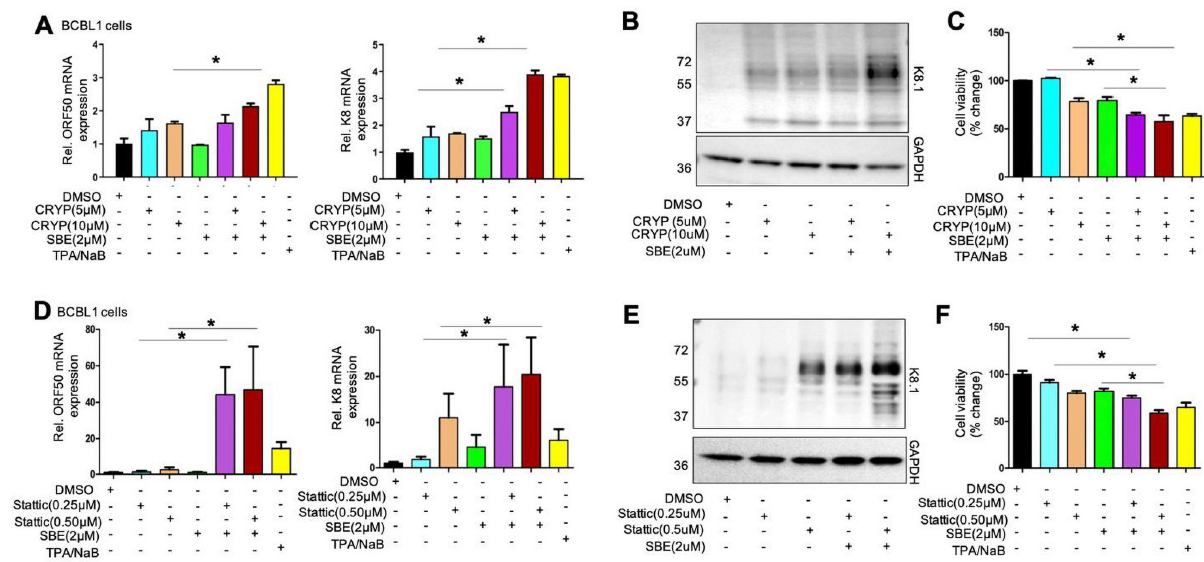
Fig 5. Inhibition of PLK1 and STAT3 efficiently induces KSHV lytic reactivation. (A, D) BCBL1 cells were treated with cryptotanshinone (CRYP, A) or stattic (D) in the presence or absence of SBE. TPA/NaB treatment was used as a positive control to reactivate latent KSHV. mRNA level of KSHV lytic genes (ORF50, K8) in these cells were measured by RT-qPCR and normalized to GAPDH. (B, E) Protein level of KSHV K8.1 in above cells (A, D) was measured by immunoblotting. GAPDH was used as loading control. (C, F) Cell viability of above cells (A, D) was measured by ATP-based assays and normalized to DMSO. Results were calculated from n = 3 independent experiments and presented as mean ± SD ( � p < 0.05; two-tailed paired Student t-test).